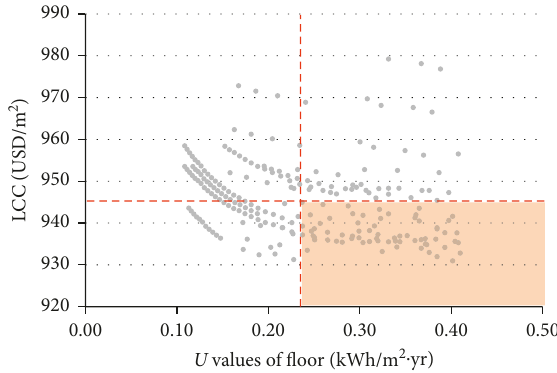
Figure 8: LCC according to the U values of the floors.